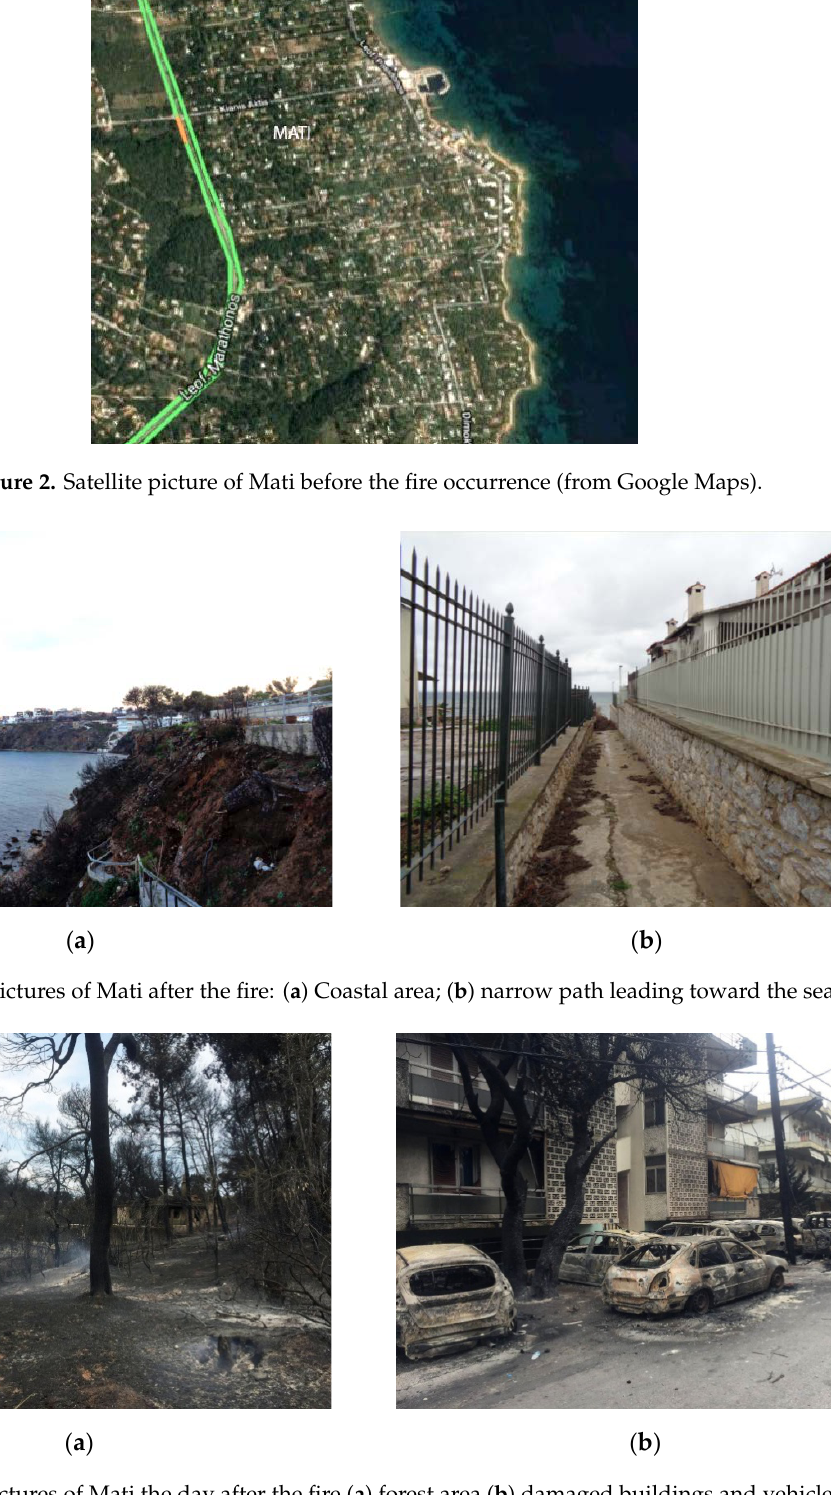
Figure 4. Pictures of Mati the day after the fire (a) forest area (b) damaged buildings and vehicles.